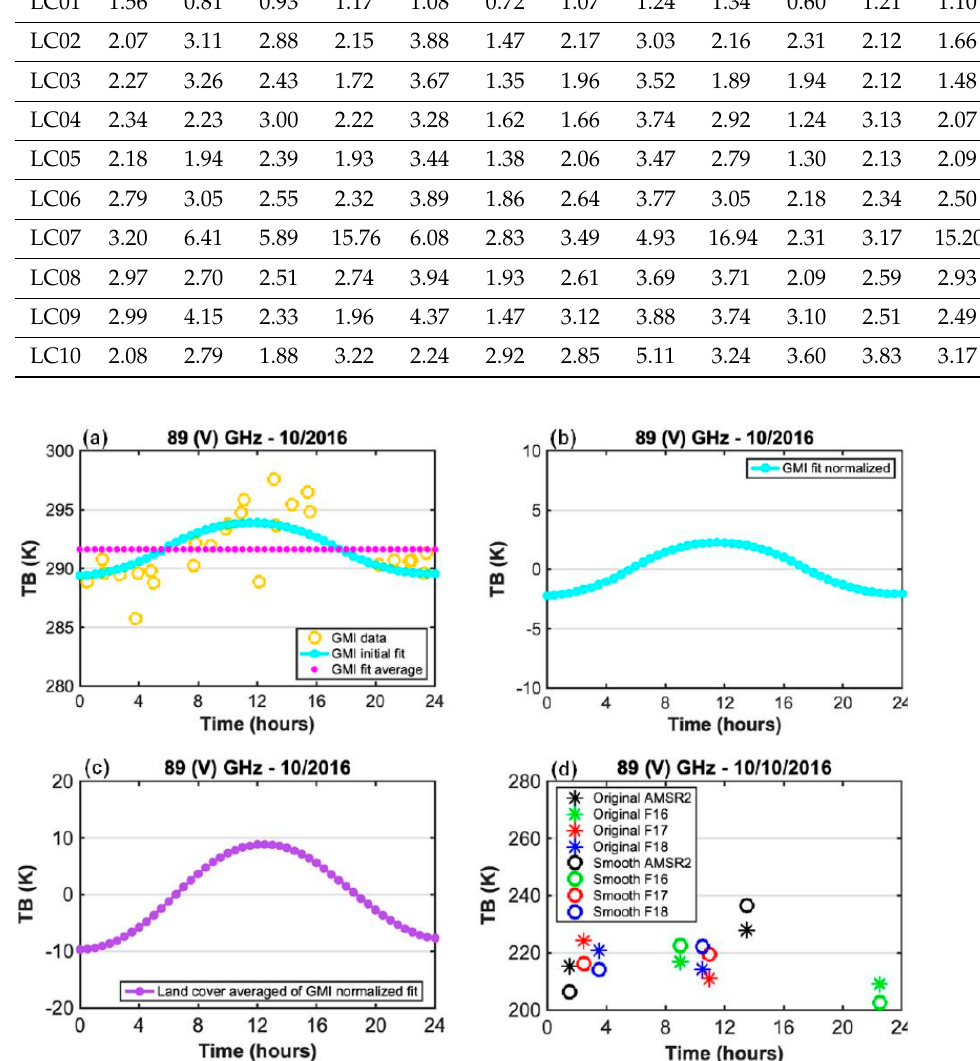
Figure 5. Steps for SSMIS/AMSR2 data smoothing for regions above latitude 68 ◦ N and below latitude 68 ◦ S at 89 GHz vertical polarization. ( a ) Initial GPM Microwave Imager (GMI) fit and its average for a sample location at 13.9 ◦ N and 14 ◦ W with deciduous woodland land cover for October 2016; ( b ) normalized GMI fit by taking away the average from the initial fit for the same location and month; ( c ) the average of all the GMI normalized plots for pixels with the same land cover and month; ( d ) smoothing of the original SSMIS/AMSR2 data for a sample location at 71.2 ◦ N and 103 ◦ E with the same land cover and month by applying the land cover-averaged normalized plot on the corresponding time for 10 October 2016. Time in each subplot is in local solar hours. Finally, the spline fit was applied to the smoothed AMSR2, SSMIS F16, SSMIS F17, and SSMIS F18 data to estimate the half-hourly TB diurnal cycle in polar regions. Final TB diurnal interpolations at 18.7 GHz (H) for four sample locations (three in Northern and one in Southern Hemisphere) having distinct land cover types are shown in Figure 6. As expected, the magnitude and timing of maximum TBs are notably different for distinct land cover